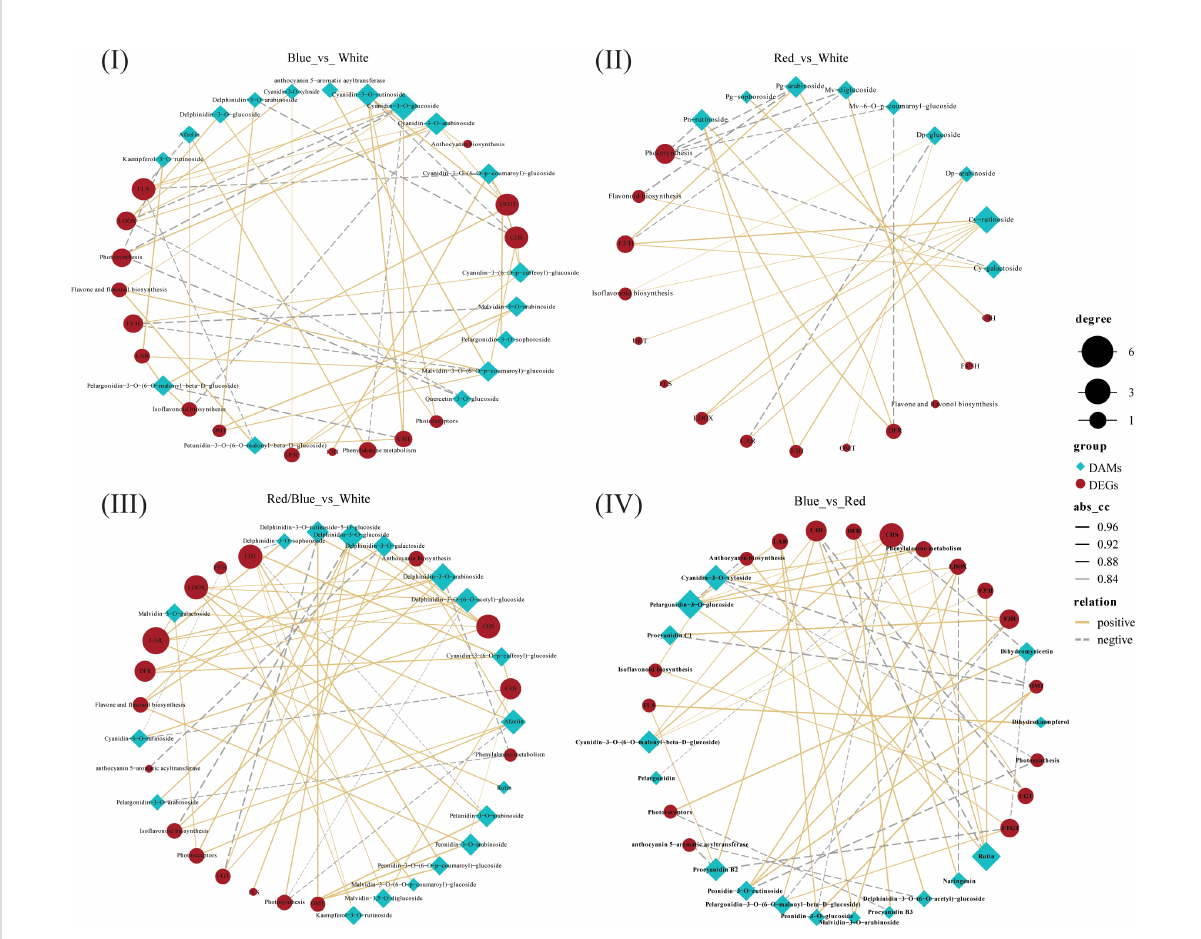
FIGURE 8 Results of the correlation analysis for the differentially expressed genes (DEGs) and differentially accumulated metabolites (DAMs) involved in the anthocyanin biosynthesis pathway of blueberry leaves based on the correlation coef fi cient (CC) and the p-value for the correlation coef fi cient (CCP) between DAMs and DEGs. Analysis of (I) blue vs. white, (II) red vs. white, (III) red/blue vs. white, and (IV) blue vs. red. The size of the black dots indicates the number of connected DAMs or DEGs; the width of the connecting lines indicates the strength of the correlation; solid lines indicate positive correlations and dashed lines indicate negative